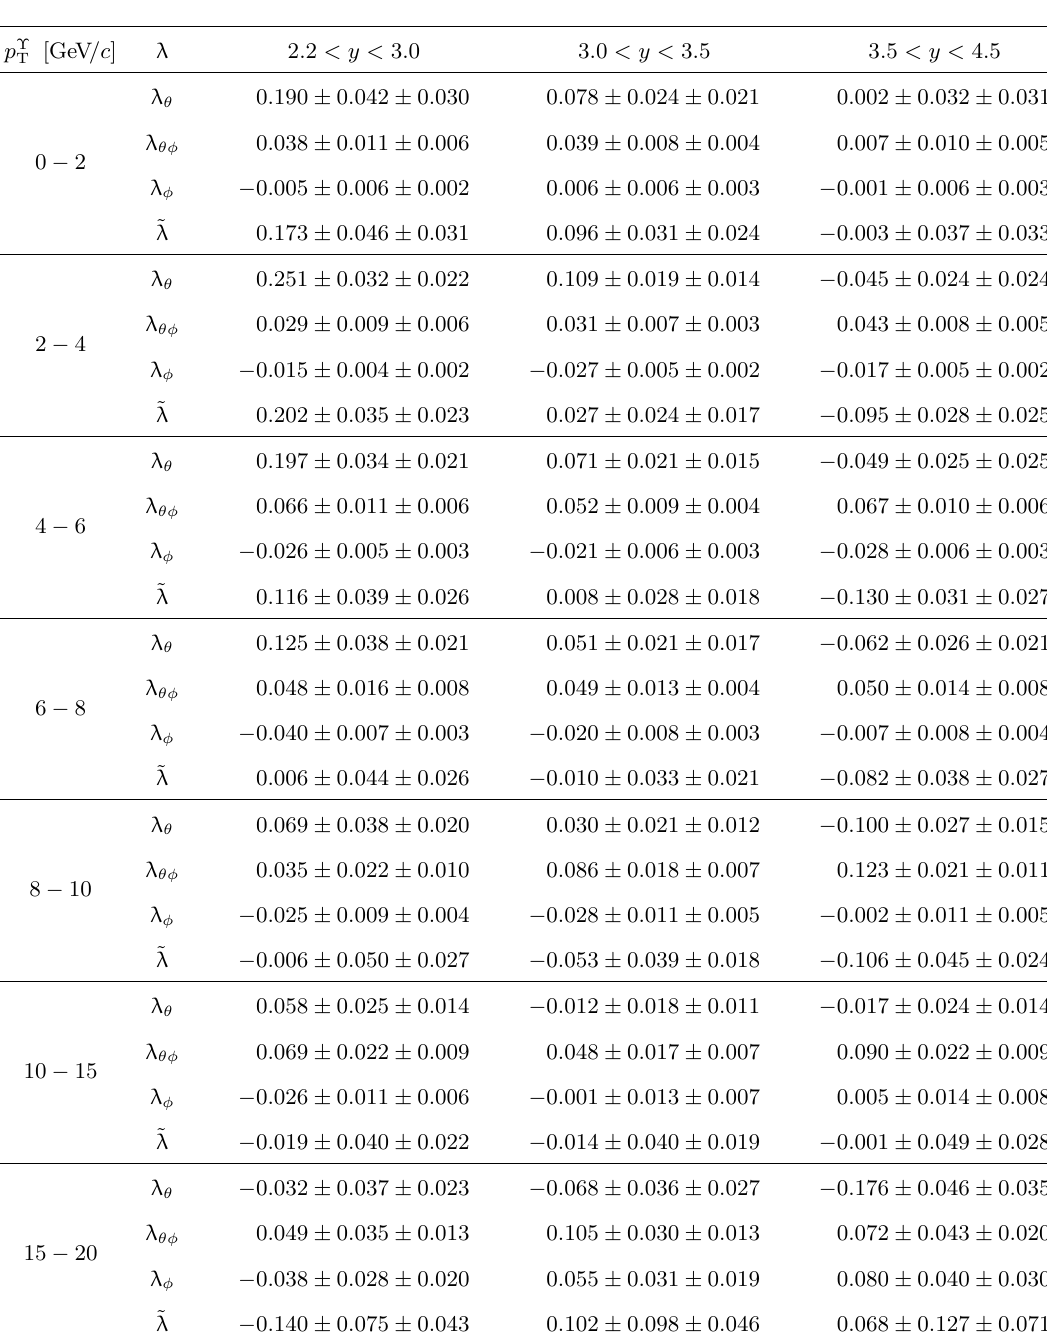
Table 5 . Values of (cid:21) (cid:18) , (cid:21) (cid:18)(cid:30) , (cid:21) (cid:30) and ~ (cid:21) measured in the CS frame for the (cid:7)(1S) produced at p s = 8 TeV. The (cid:12)rst uncertainty is statistical and the second systematic.